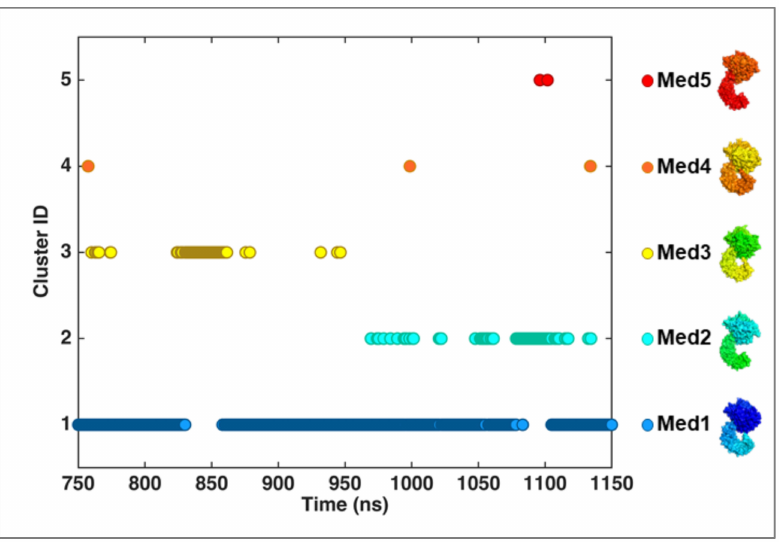
Figure 6. Cluster ID over simulation time (ns). For comparison, a surface representation of the medoid structure belonging to each cluster ID is displayed on the